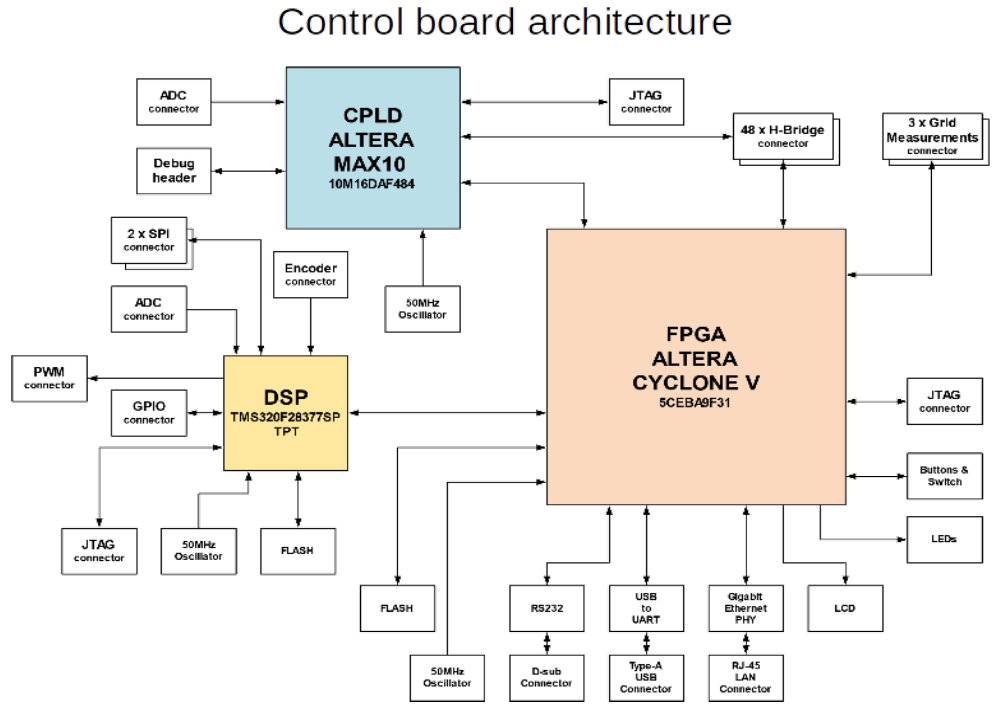
Figure 15. Control board